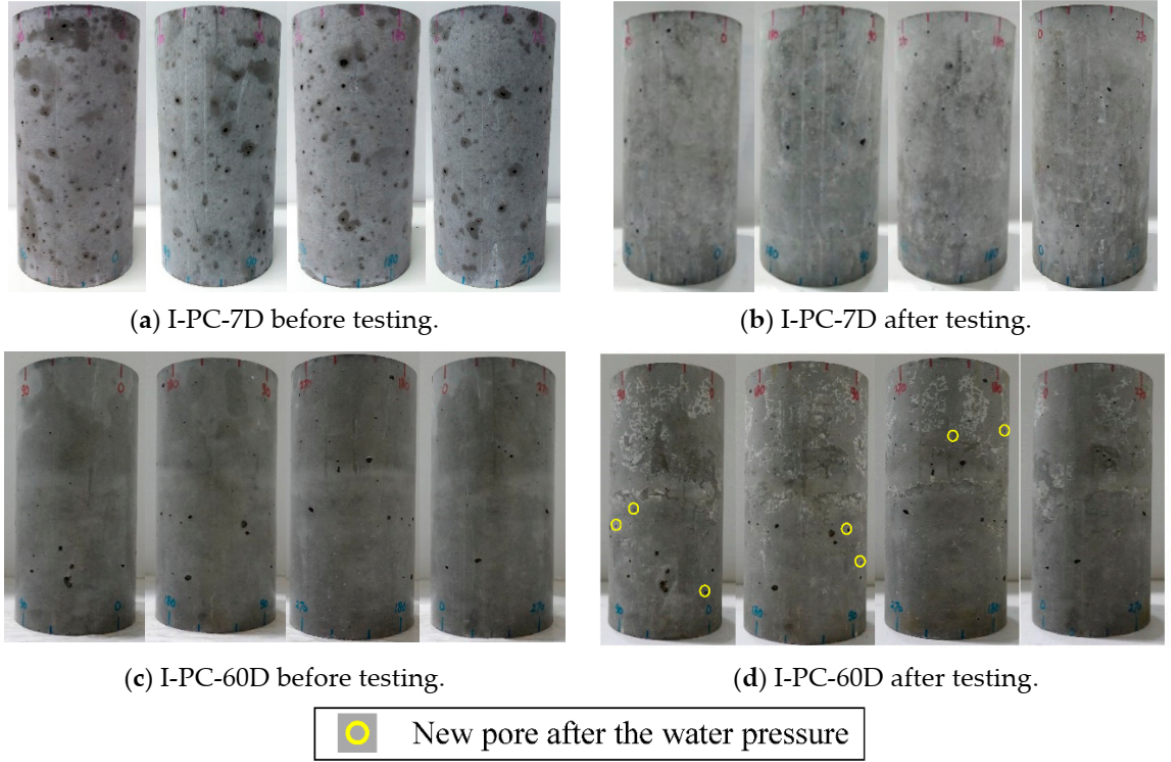
Figure 7. Specimen surface condition for series I under sustained high water pressure.